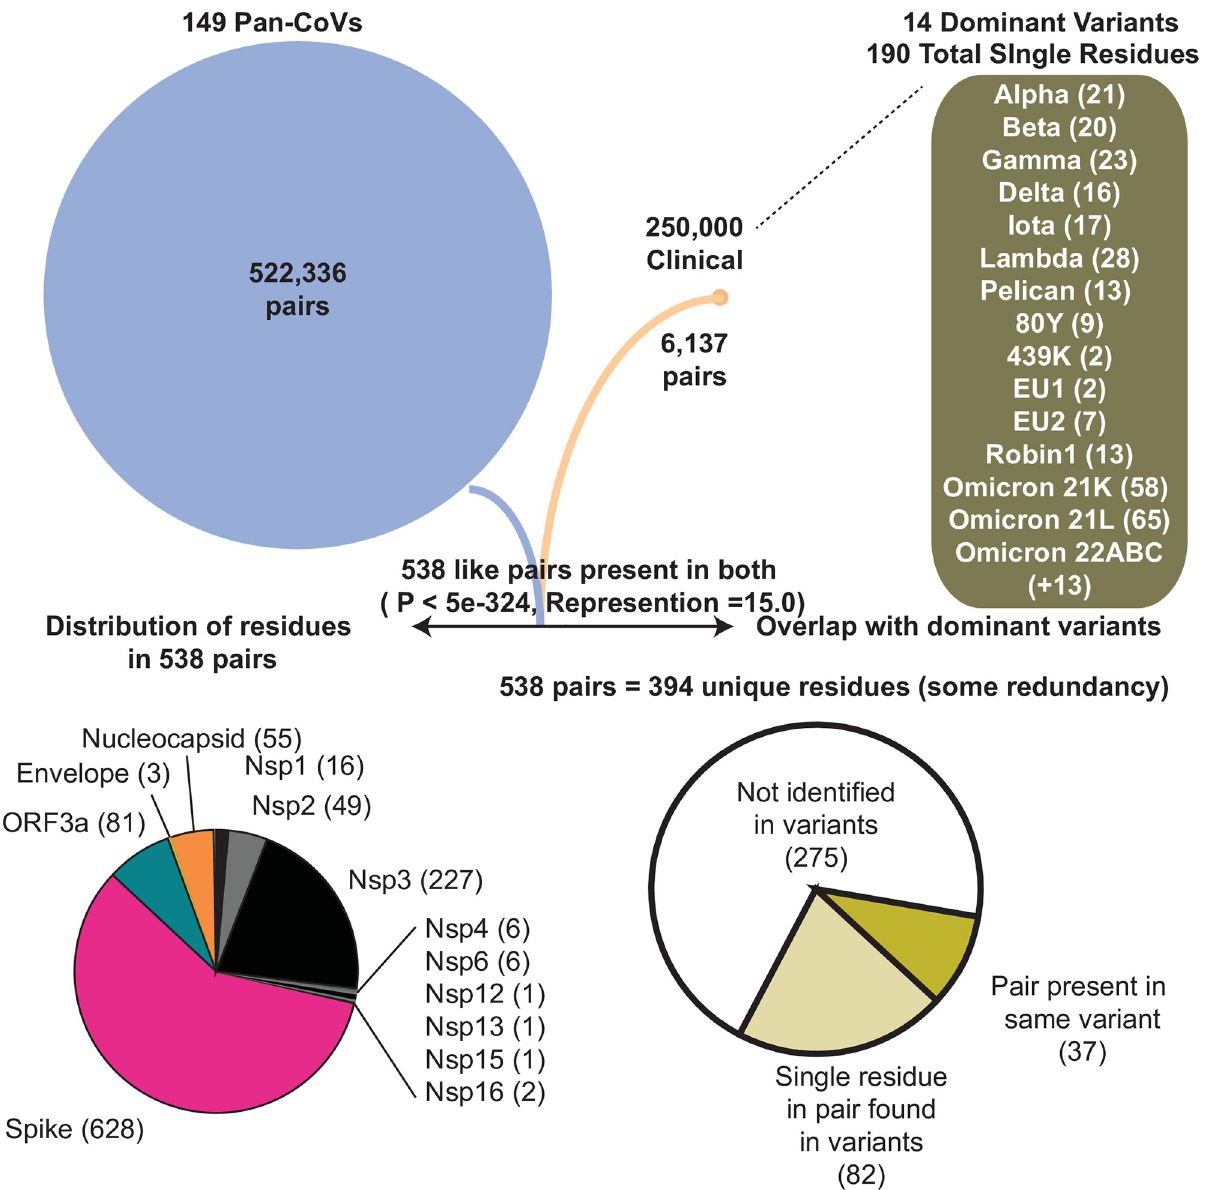
Fig 7. Flow chart showing the accounting of identified pan and clinical covariant residues and overlap. 14 dominant variants used in comparative analyses and respective residues found in each are shown in parenthesis. The WHO label for each variant is used for reference. The gene by gene distribution of the 538 co-present pairs in genes is graphed. The abundance and overlap of pairs and single residues identified in the 14 dominant lineages are graphed. Hypergeometric probability of common residues is shown and the representation value indicates the overlap value divided by the number of expected pairs to overlap if all covariant pairs were equally